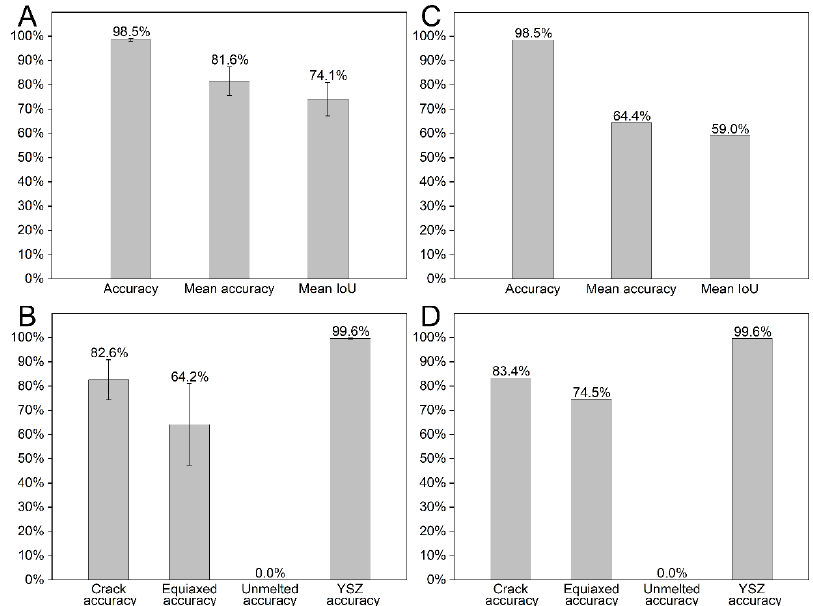
Figure 12. ( A , B ) Metrics of the trained model evaluated using 39 more typical APS TBC images selected from all the 57 test images: ( A ) Overall metrics and ( B ) accuracy for each class of microstructure; the error bars represent standard deviations. ( C , D ) Metrics of the trained model evaluated using one hypothetical image containing all 39 more typical APS TBC images: ( A ) overall metrics and ( B ) accuracy for each class of microstructure.